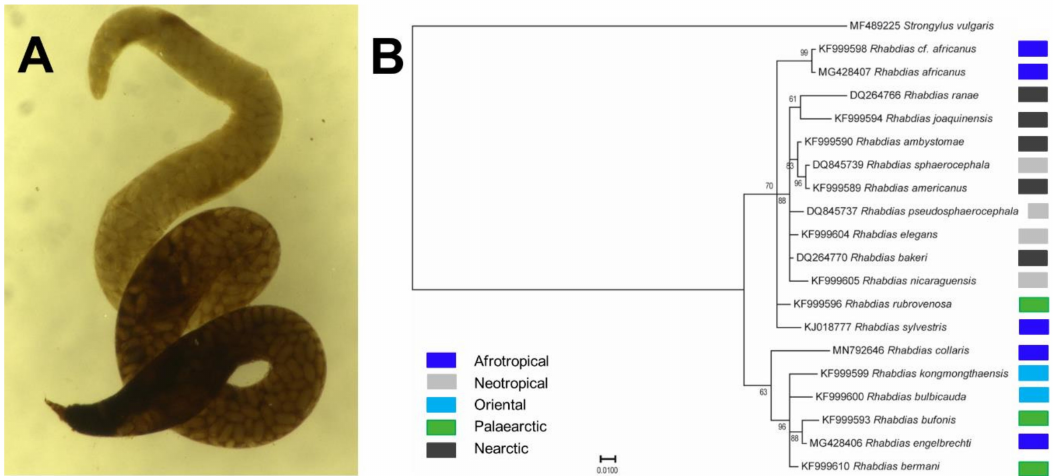
Figure 4. ( A ) Live Rhabdias collaris female (6.1 mm body length) from the lung of a H. viridiflavus male. ( B ) Bayesian tree of ITS1 rDNA sequences of Rhabdias nematodes deposited in GenBank including R. collaris collected from H. viridiflavus , rooted by the strongylid Strongylus vulgaris . Posterior probability values are indicated. Scale bar indicates substitutions per site. Association of parasites to biogeographic realms is color-coded.